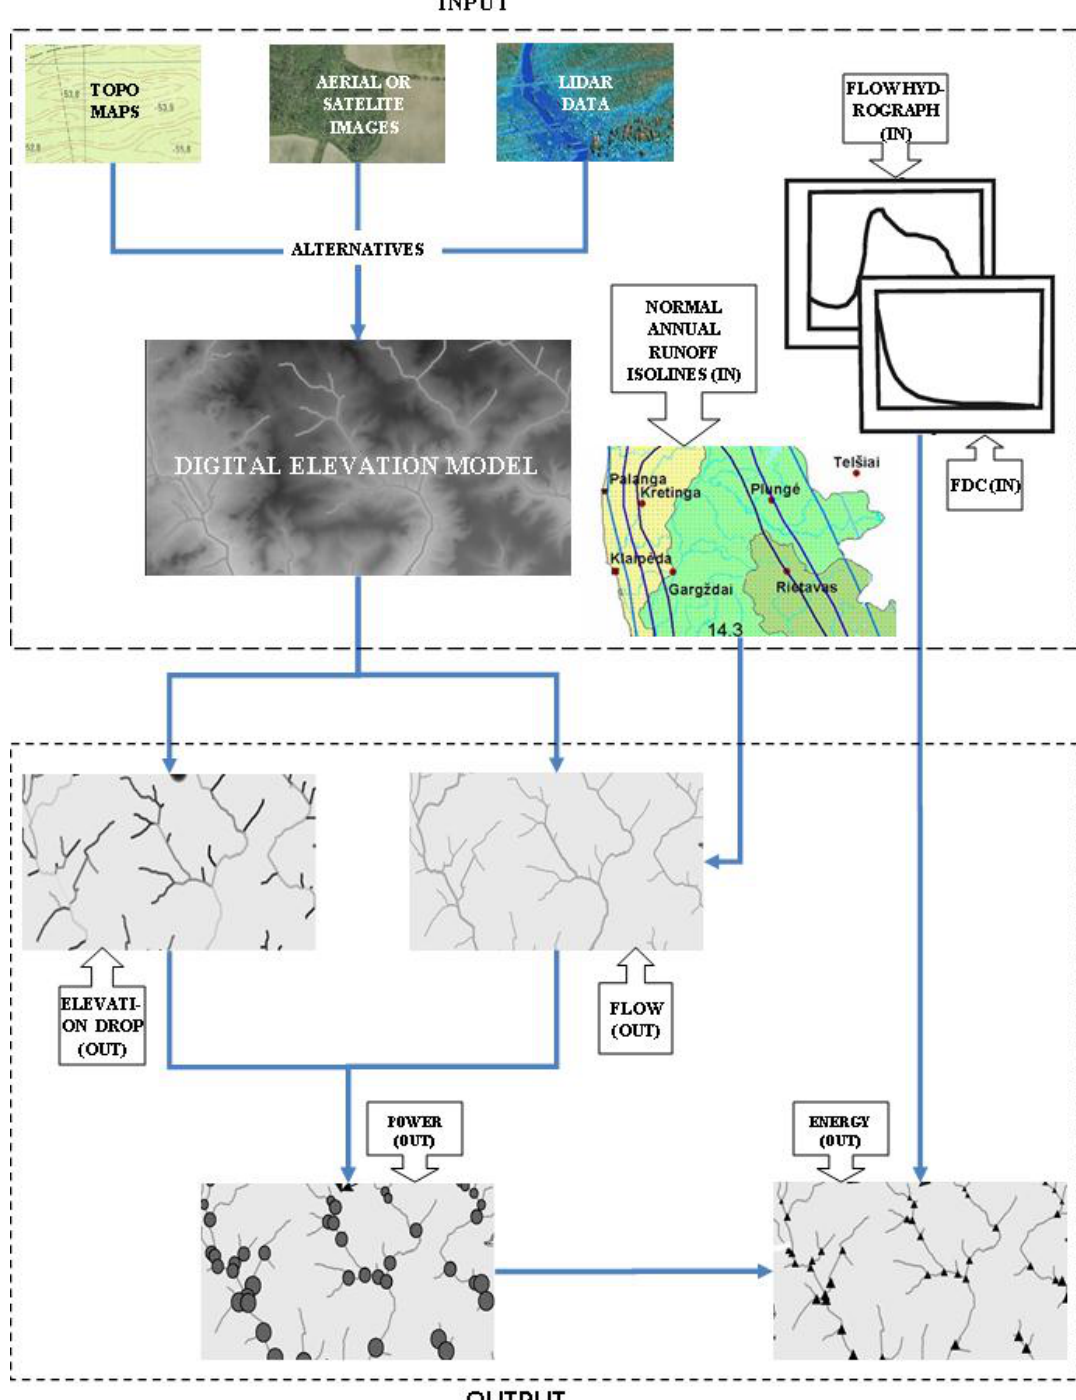
Figure 2. GIS hydropower assessment tool. General model process